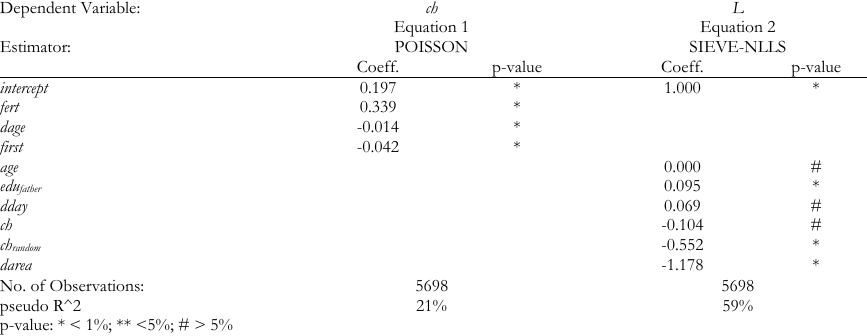
Reduced form estimation of fertility and of participation function ch L Equation 1 Equation 2 Estimator: SIEVE-NLLS Coeff.